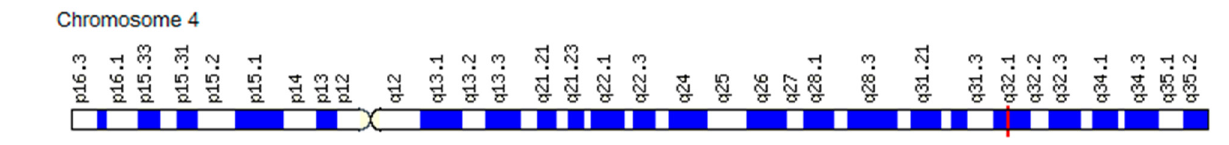
Figure 4. Localization of the PDGF-C gene on chromosome 4q32.1.